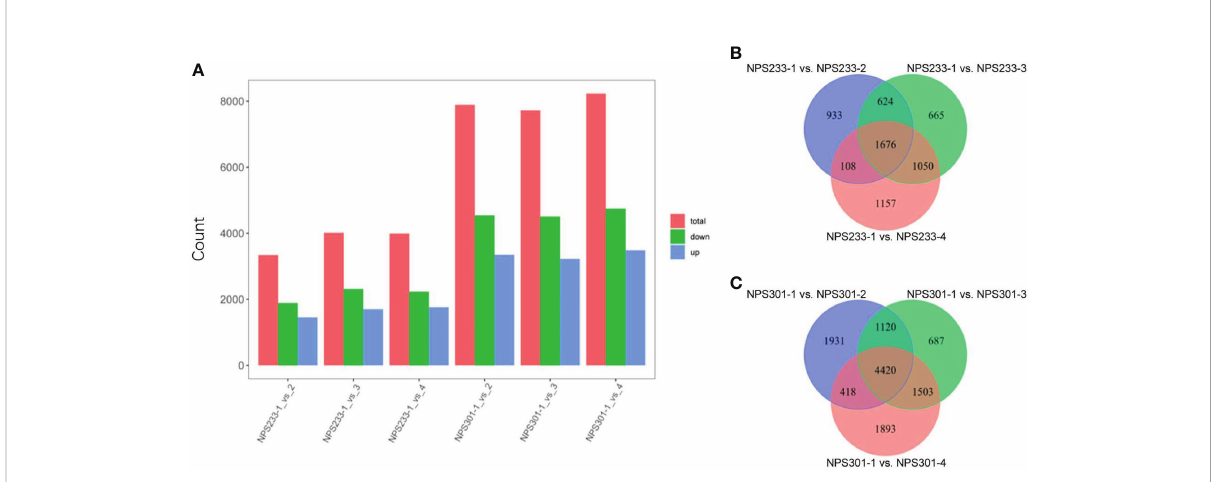
FIGURE 2 Differentially expressed genes in the six compared groups from NPS233 and NPS301. (A) Number of DEGs identi fi ed through the comparative analysis. (B, C) Venn diagrams depicting the DEGs between pairwise comparisons of seed samples from NPS233 and